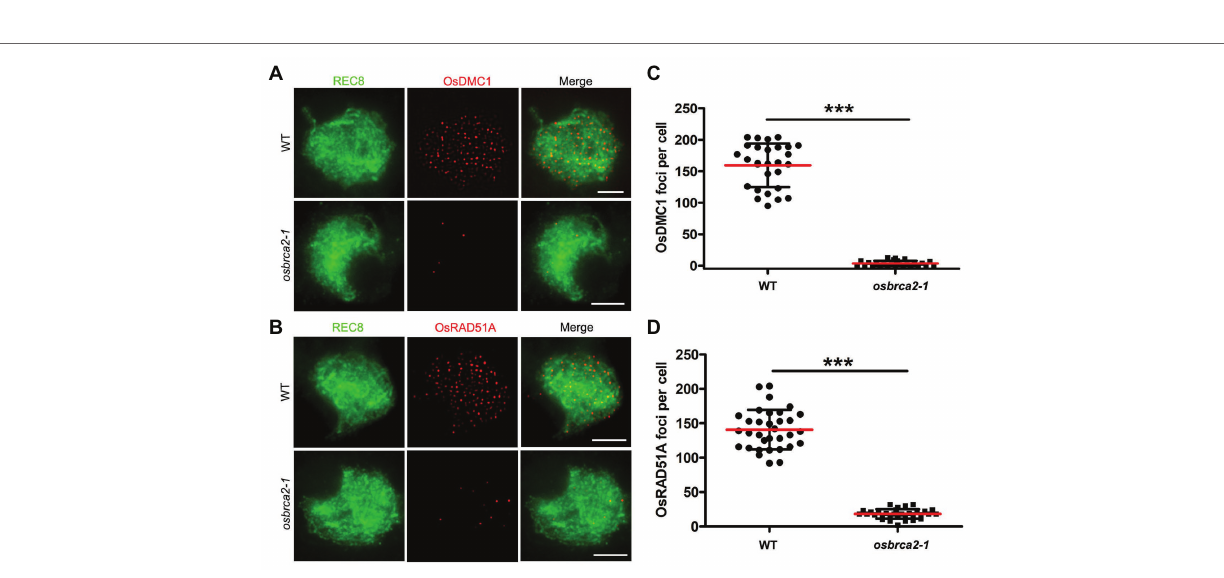
FIGURE 7 | DMC1and RAD51A are not able to load on meiotic chromosomes in osbrca2-1 . (A) Immunolocalization of DMC1 (red) and OsREC8 (green) in wild- type and osbrca2-1 meiocytes at zygotene. (B) Immunolocalization of RAD51A (red) and OsREC8 (green) in wild-type and osbrca2-1 meiocytes at zygotene. (C) Statistical analysis of the number of OsDMC1 foci per cell in wild type ( n = 28) and osbrca2-1 mutants ( n = 26). (D) Statistical analysis of the number of OsRAD51A foci per cell in wild type ( n = 33) and osbrca2-1 mutants ( n = 32). All values represent the mean ± SD, *** p < 0.0001, Student’s t tests. Bars = 2 μ m.